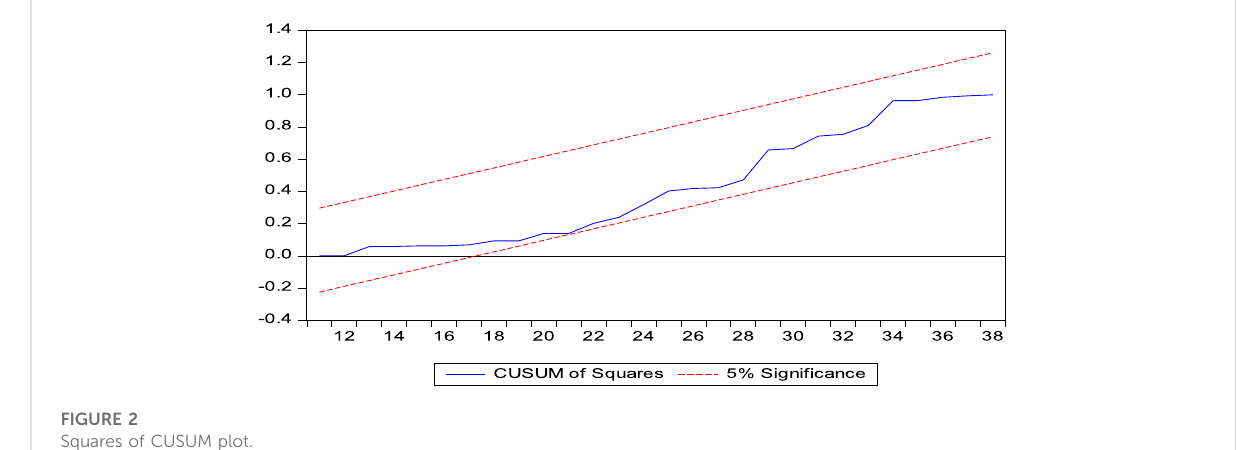
FIGURE 2 Squares of CUSUM